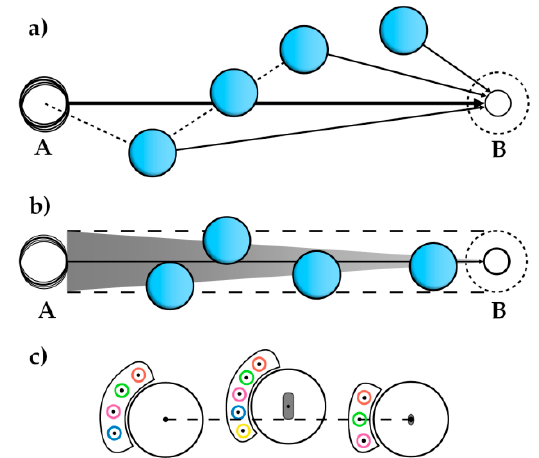
Figure 1. Interactions between the probe tip and microparticles. θ is the angle between the tip centerline and x -axis. ( a ) The tips move microparticles in a push mode, where an upward force is applied on the microparticles. ( b ) The tip moves microparticles in a drag mode, where a downward force is applied on the microparticles.